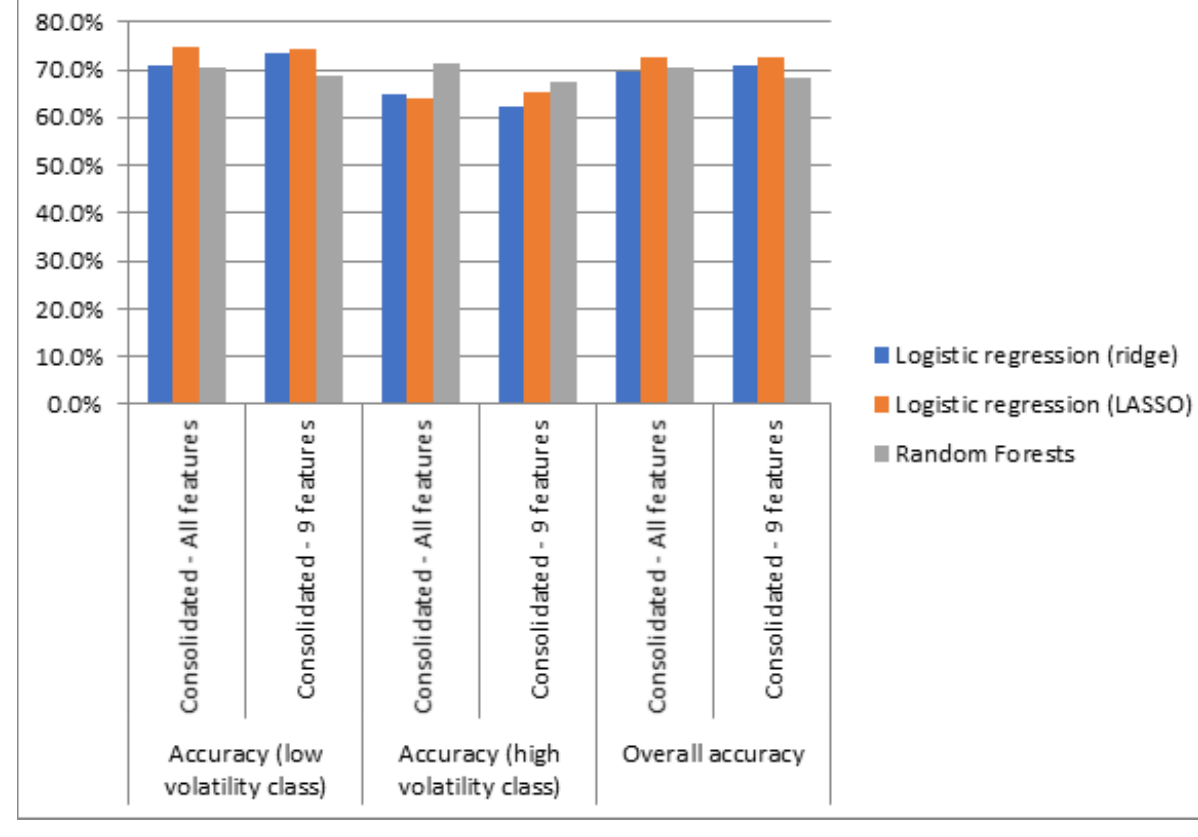
Figure 7. Standalone Equation